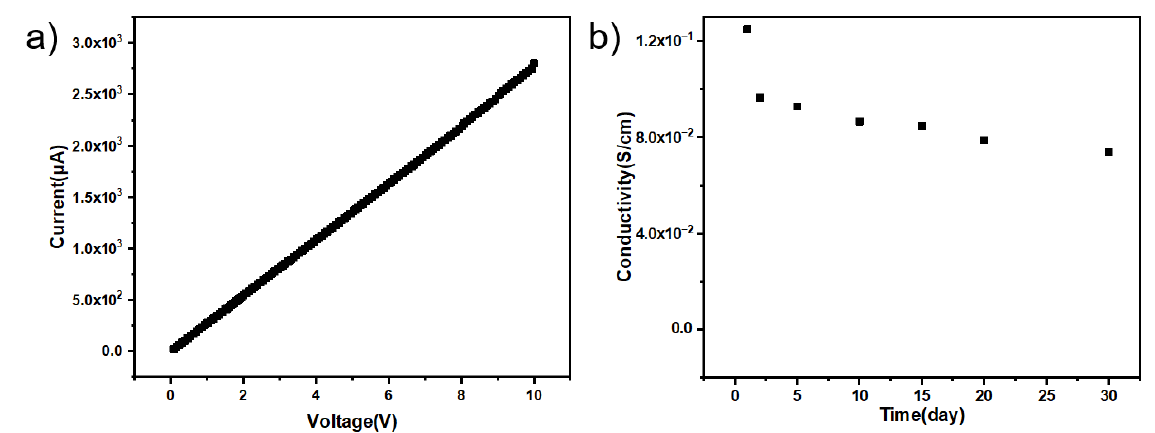
Figure 14. In-situ polymerization deposition of PPy/CNCs doped sulfonate on paper substrate ( a ) I − V curve of p -TSA-doped conductive paper (30 mm long, 5 mm wide and 100 µ m thick). ( b ) Conductivity stability of the conductive paper.